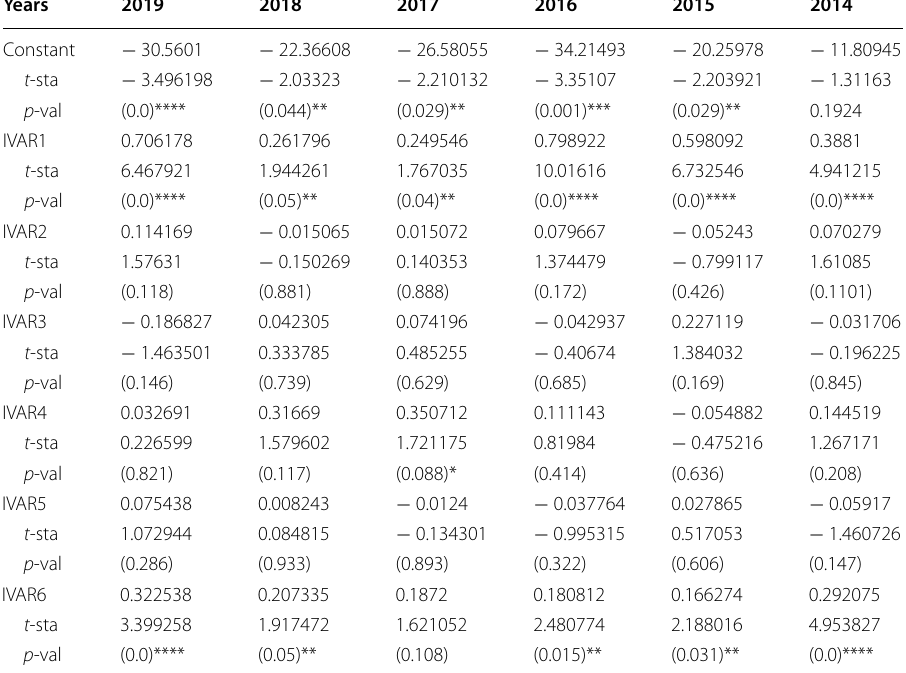
****, ***, ** and * denote statistical significance at the 0.1%, 1%, 5%, and 10% significance level, respectively. The table contains t ‑statistic and their corresponding p ‑values below in